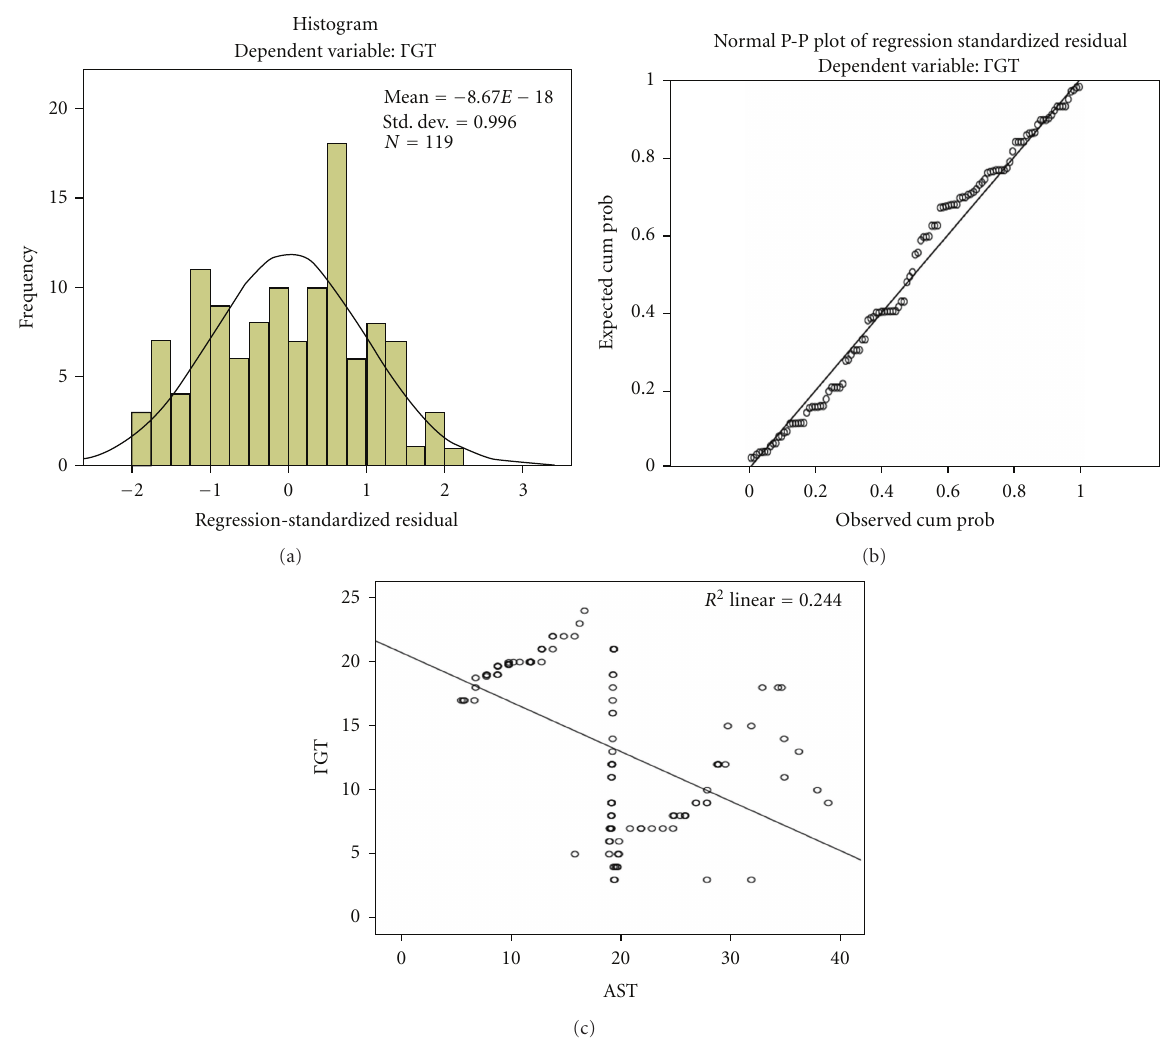
Figure 3: Frequency distribution by histogram (a) and normal P - P plot of regression-standardized residual (b) for GGT as dependent variable and AST as the only independent determinant (c) during day 0–day 60 anti-TB therapy of initial